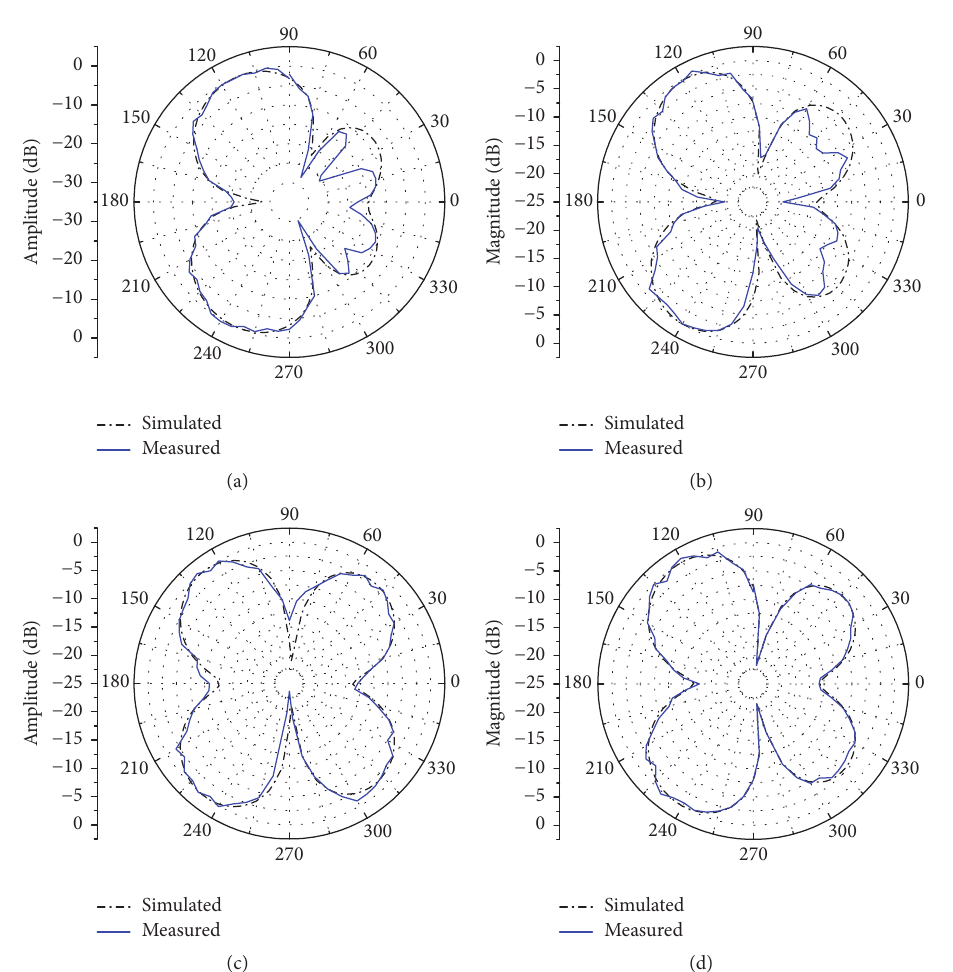
Figure 10: Simulated and measured radiation pattern for different values of 𝑡 02 at 2.45 GHz. (a) 𝑡 02 = 0 𝜇 sec. (b) 𝑡 02 = 0.125 𝜇 sec. (c) = 0.25 𝜇 sec. (d) 𝑡 = 0.375 𝜇 𝑡 02 02